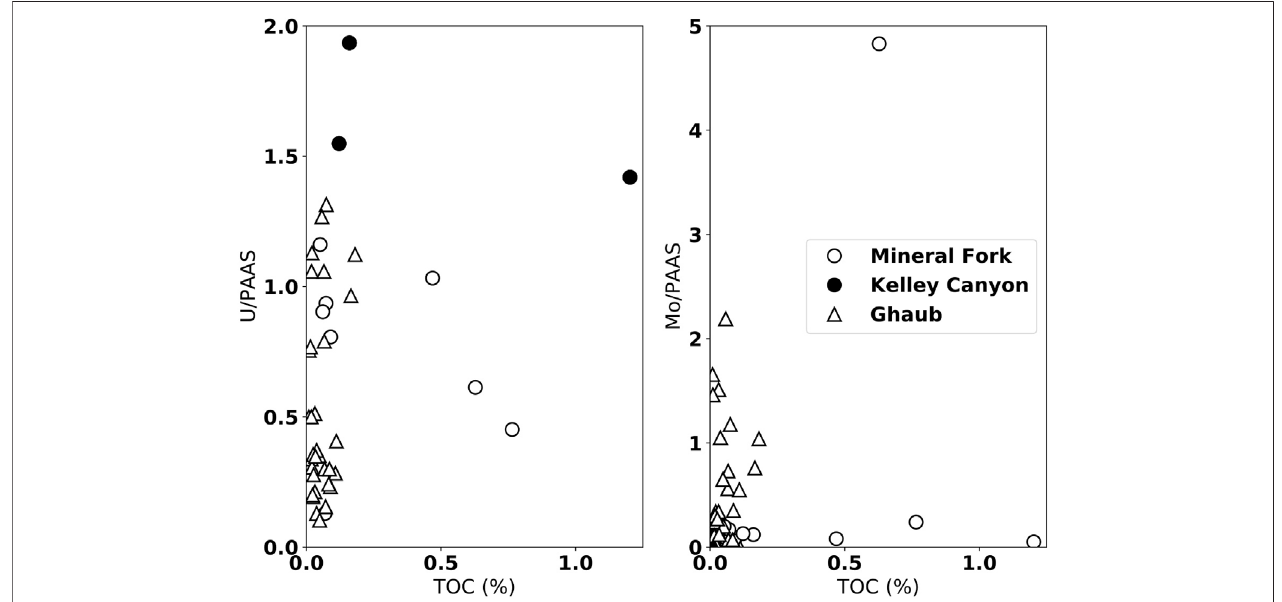
FIGURE4| UraniumandMoconcentrations,normalizedtoPost-ArcheanAverageShale(PAAS),plottedagainstcarbonconcentration(ppm)fromtheMineralfork (open circles), Kelley Canyon (closed circles), and the Ghaub Formation (triangles). There is no clear correlation between either, suggesting limited in fl uence of organic carbon availability on trace metal concentration in sediments.